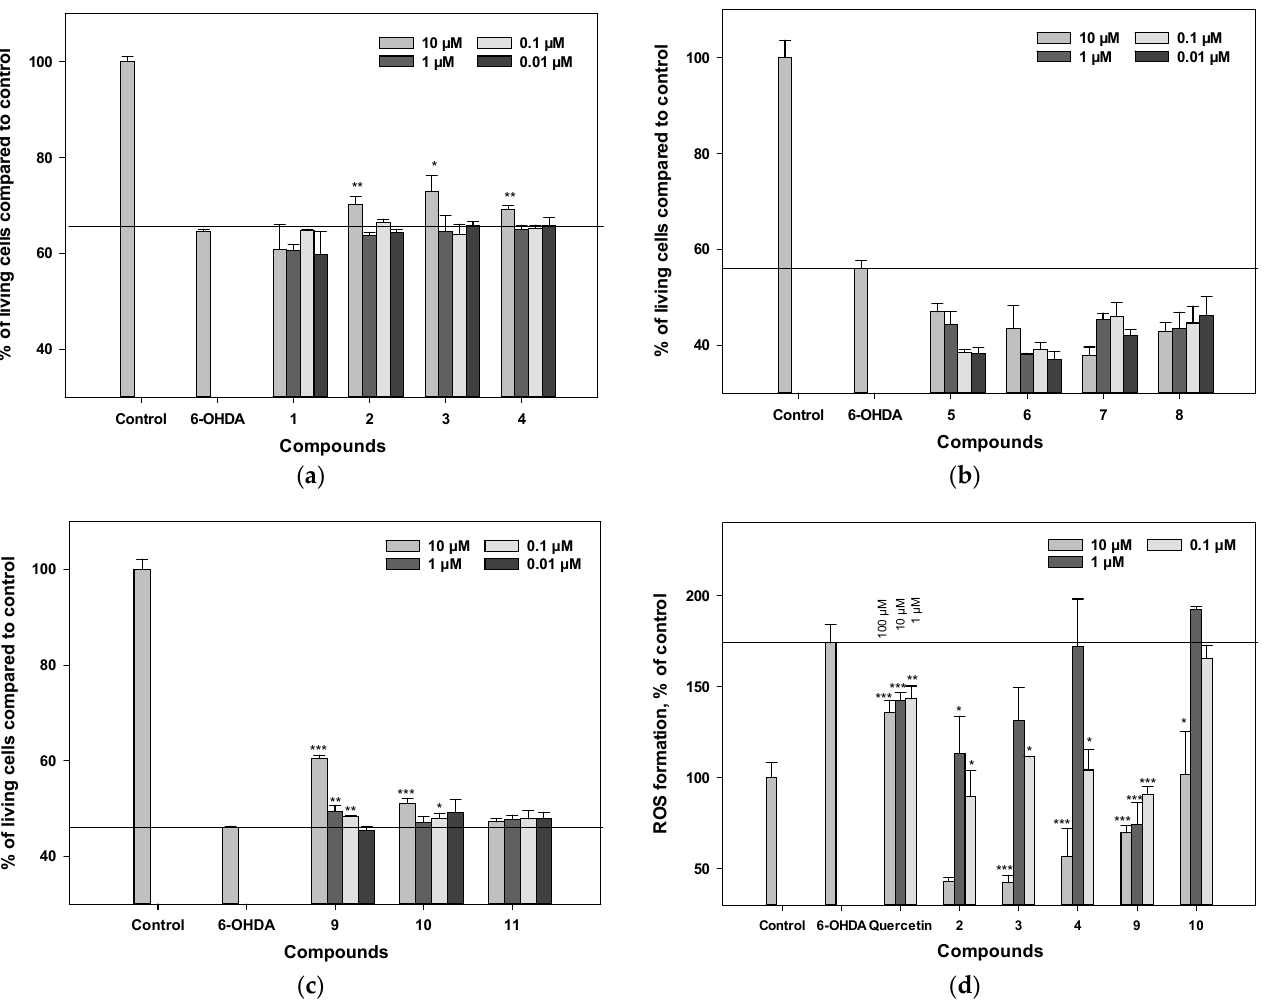
Figure 4. The influence of polyphenolic compounds from L. bicolor on cell viability ( a – c ) and ROS levels ( d ) in Neuro-2a cells treated with 6-OHDA (80 µM). The percentage of living cells treated with compounds and 6-OHDA was measured by MTT assay. Each bar represents the mean ± SEM of three independent replicates. (*), (**), and (***) indicate, respectively, p < 0.05, p < 0.005, and p < 0.001 versus 6-OHDA-treated cells. The difference between control and 6-OHDA-treated cells was considered significant.